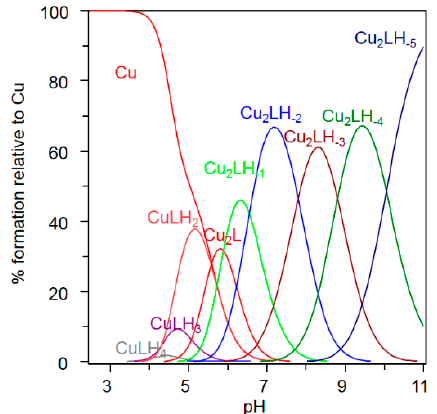
Figure 4. Species distribution for the Cu 2+ -Ctr1 (1-14) system. C Ctr1 = 2.5 × 10 − 5 mol dm − 3 ; Cu 2+ /Ctr1 (1-14) concentration ratio is 1.9.